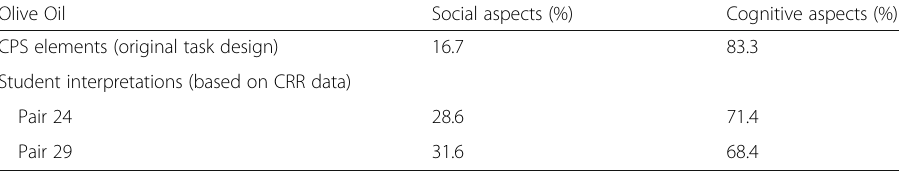
Table 8 Relative frequency distributions of the social and cognitive aspects (Olive Oil) Olive Oil Social aspects